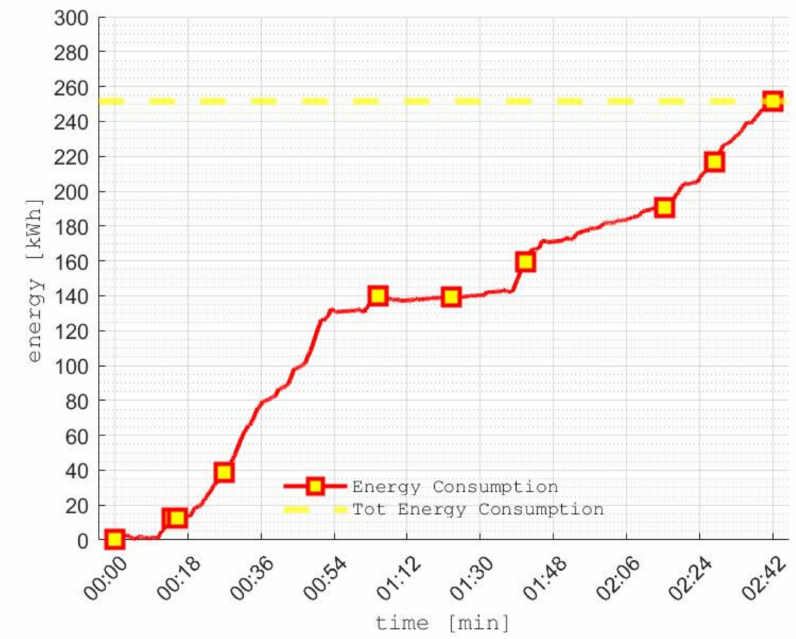
Figure 9. Energy